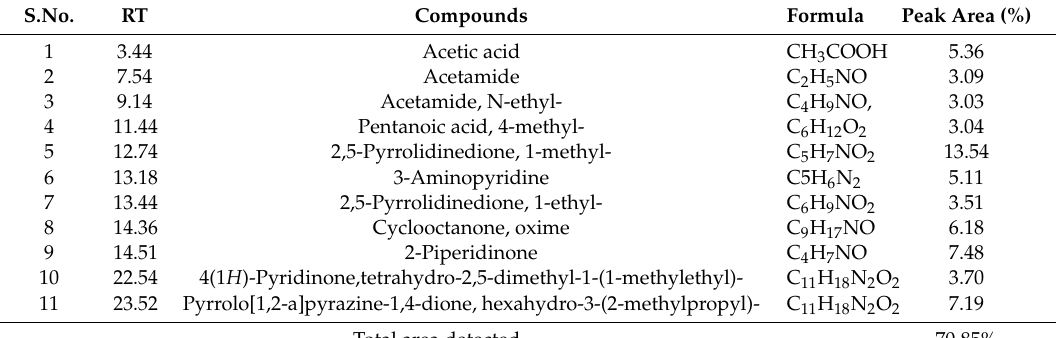
Figure 9. Carbon recovery in HTL products via aqueous phase recycling. Table 7. Compound composition of aqueous phase produced after the second recycle